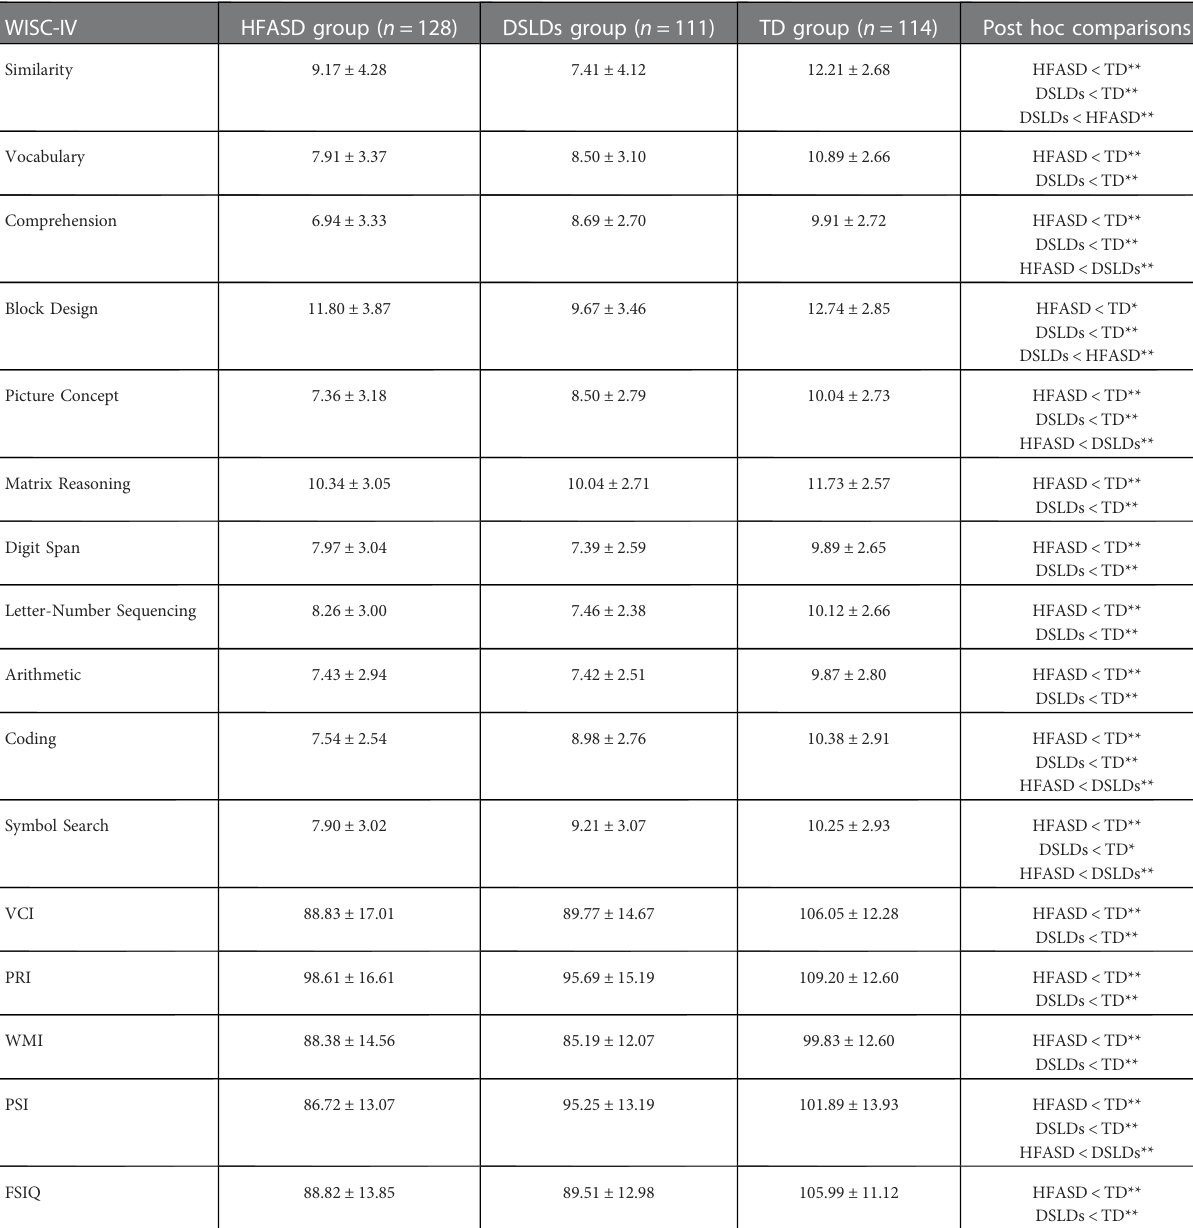
TABLE 2 Comparisons of intelligence pro fi les among the HFASD, DSLDs and TD groups. WISC-IV HFASD group ( n = 128) DSLDs group ( n =